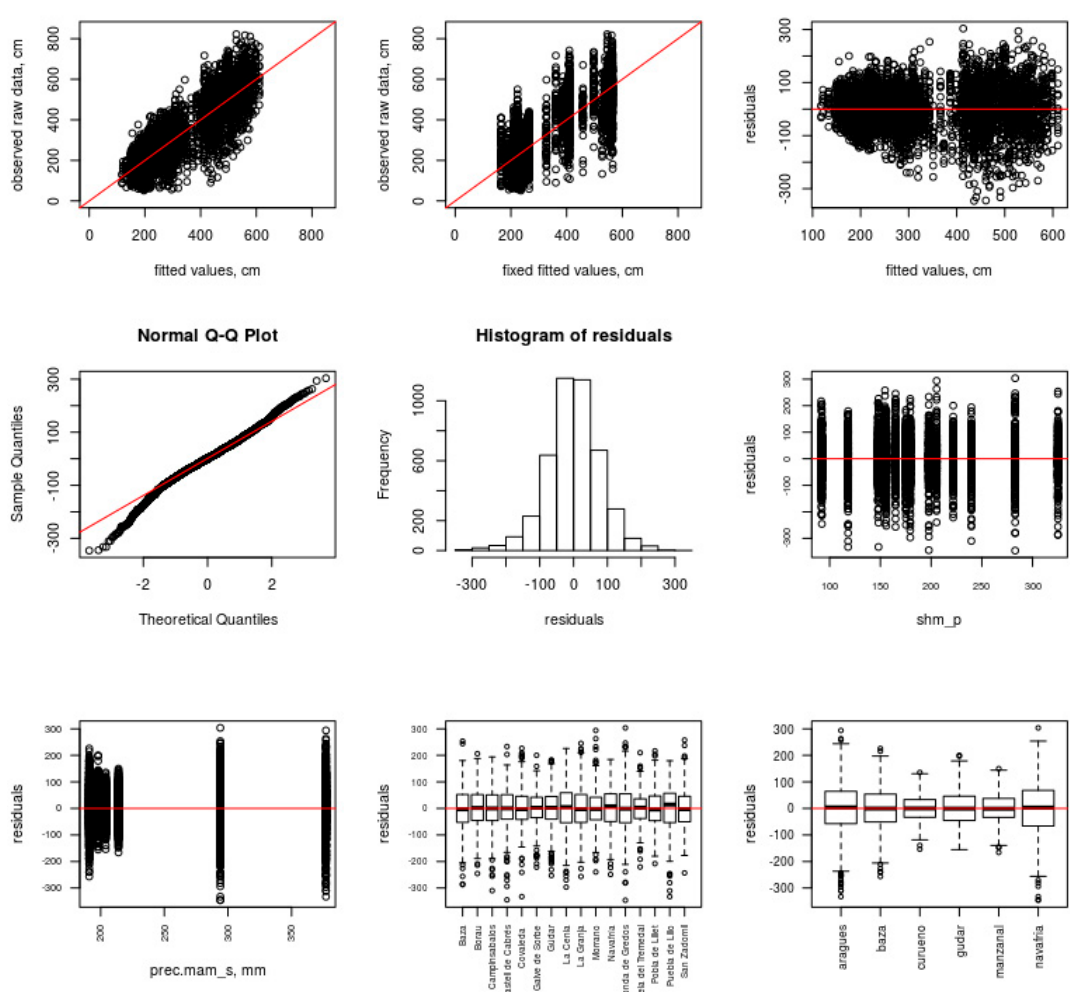
Figure A2. Graphical summary of the best supported model for Scots pine populations from 15 year-old. Top line, left to right: plot of observed raw data vs. predicted; plot of observed raw data vs. predicted data; residuals vs. predicted data. Middle line: qq-plot; histogram of residuals values; residuals vs. shm_p (summer heat moisture index). Bottom line: residuals vs. prec.mam_s (spring precipitation); residuals vs. population factor; residuals vs. planting site factor.